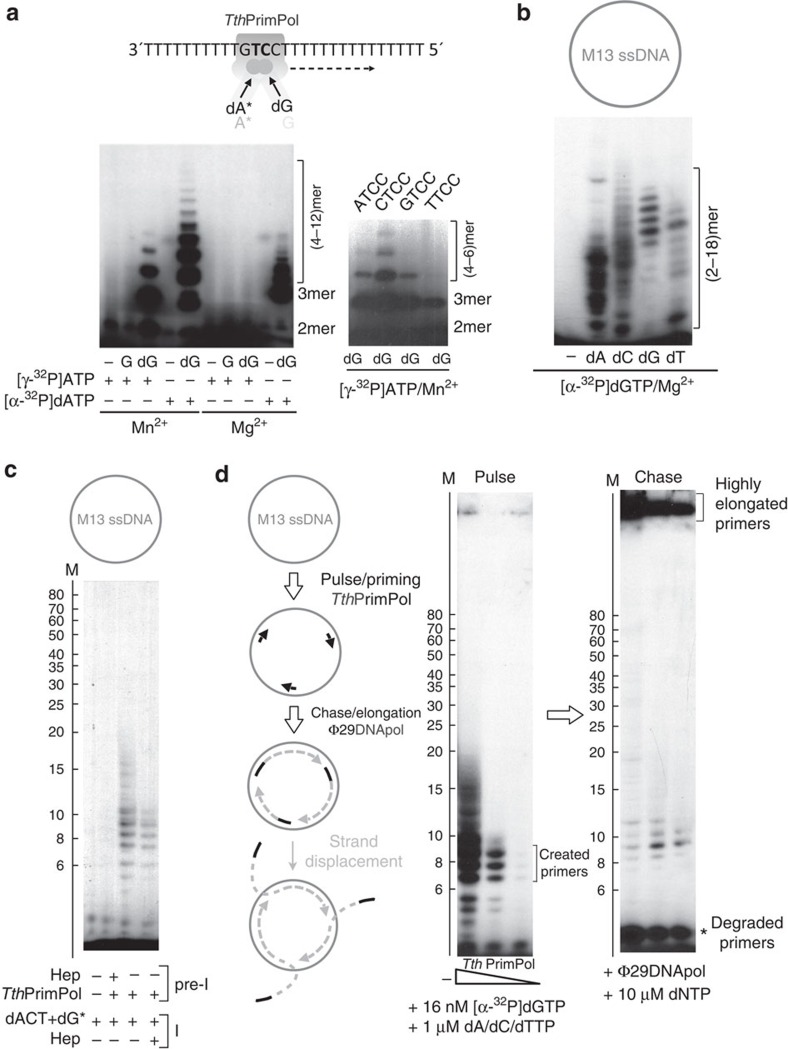
TthPrimPol is a DNA primase that can be coupled to processive elongation by Φ29DNApol.(a) Left panel: metal and sugar selectivity of TthPrimPol primase activity. 3′-GTCC-5′ oligonucleotide (1 μM) was used as a preferred template. Labelled nucleotide [γ-32P] ATP or [α-32P] dATP nM) were alternatively used as 5′-nucleotide and either unlabelled GTP or dGTP (10 μM) were tested as 3′-nucleotide to form the initiating dimer. Primer synthesis mediated by TthPrimPol (400 nM) was evaluated either with 1 mM MnCl2 or 5 mM MgCl2 at 55 °C during 60 min. Right panel: recognition of the priming site. The assay was as in the left panel, but using templates differing in the base preceding the primase initiation site (…XTCC…) and the indicated metal and nucleotides. (b) TthPrimPol-mediated DNA primer synthesis at 30 °C occurs at multiple sites on a heterogeneous ssDNA template. TthPrimPol (100 nM) was able to generate DNA primers on circular M13mp18 ssDNA (5 ng μl−1), when using four alternative combinations of dNTPs, implying that initiation occurred at multiple sites. In all cases, [α-32P] dGTP (16 nM) was provided to label the nascent primers, combined with either dATP, dCTP, dGTP or dTTP (1 μM), in the presence of 10 mM MgCl2 at 30 °C during 20 min. (c) To evaluate the processivity of primer synthesis by TthPrimPol, we used heparin as a competitor. TthPrimPol (10 nM) was preincubated for 5 min on ice, either in the absence/presence of heparin (1 ng μl−1). Subsequently, the reaction was complemented with M13mp18 ssDNA (5 ng μl−1), dATP, dCTP and dTTP (10 μM each), [α-32P] dGTP (16 nM; 3,000 Ci mmol−1) and heparin (1 ng μl−1) when indicated and the incubation was maintained for 10 min at 30 °C, and processed as described. (d) TthPrimPol-synthesized DNA primers are efficiently extended by Φ29DNApol. The contribution of each enzyme was assayed in two consecutive stages (pulse and chase), as indicated in the scheme. The pulse demonstrated the synthesis of primers with a mean size of 7–9 nt (left panel). During chase (right panel), Φ29DNApol generated high-molecular-weight primer-elongated products (detected at the top of the gel) and some degradation products (evidenced at the bottom).